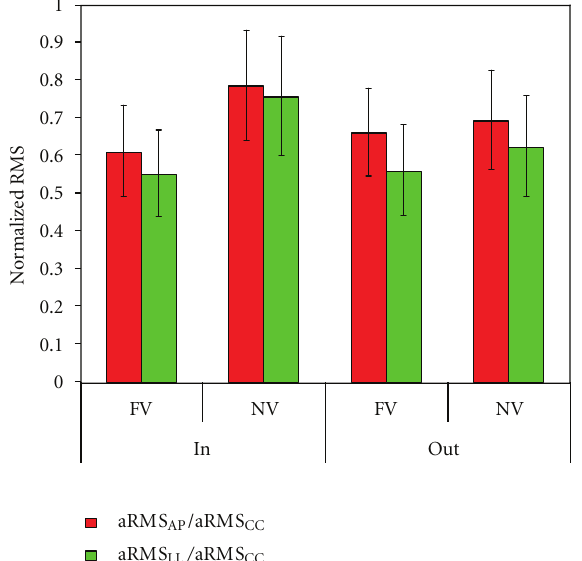
Figure 3: E ff ects of visual deprivation on gait stability in two dif- ferent environments. Mean ± standard deviation of the normalized values of acceleration root mean square along antero-posterior (red bars) and latero-lateral (green bars) directions in full-versus. no- vision conditions (FV versus NV) and in the two environments (in versus